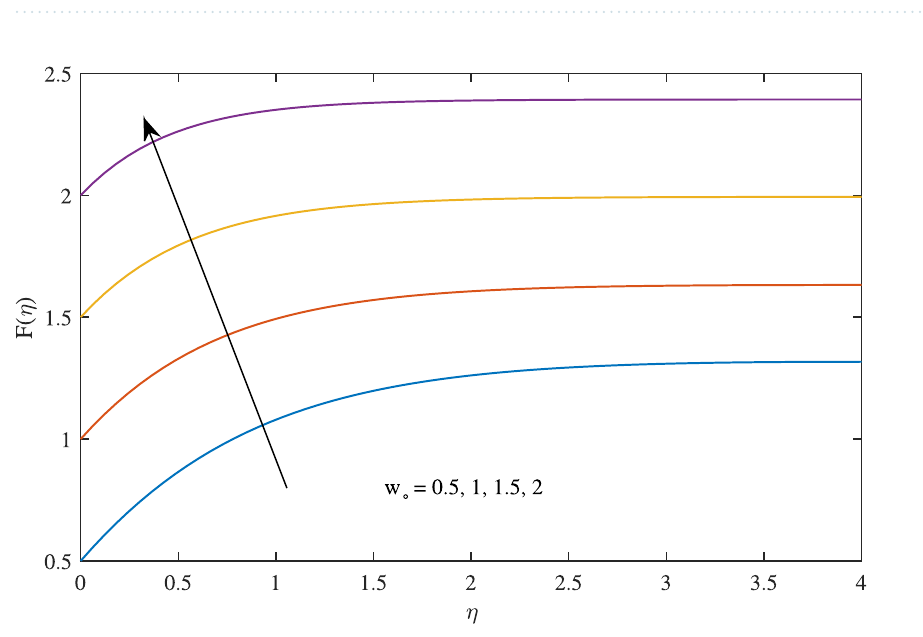
Figure 5. Effects of variation of c on temperature profile, when w 6.2 . and Pr =